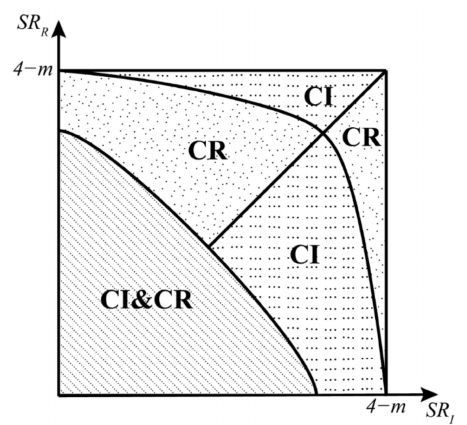
Figure 1. Which carbon abatement strategy is optimal? Note. SR I = P 2 β 2 / B and SR R = ( Pb + a ) 2 / A denote the quadratic cost savings per unit to input ratio of strategy I and R, respectively (defined in Section 5). These ratios measure the efficiency of cost savings of a carbon abatement strategy and are useful for evaluating different